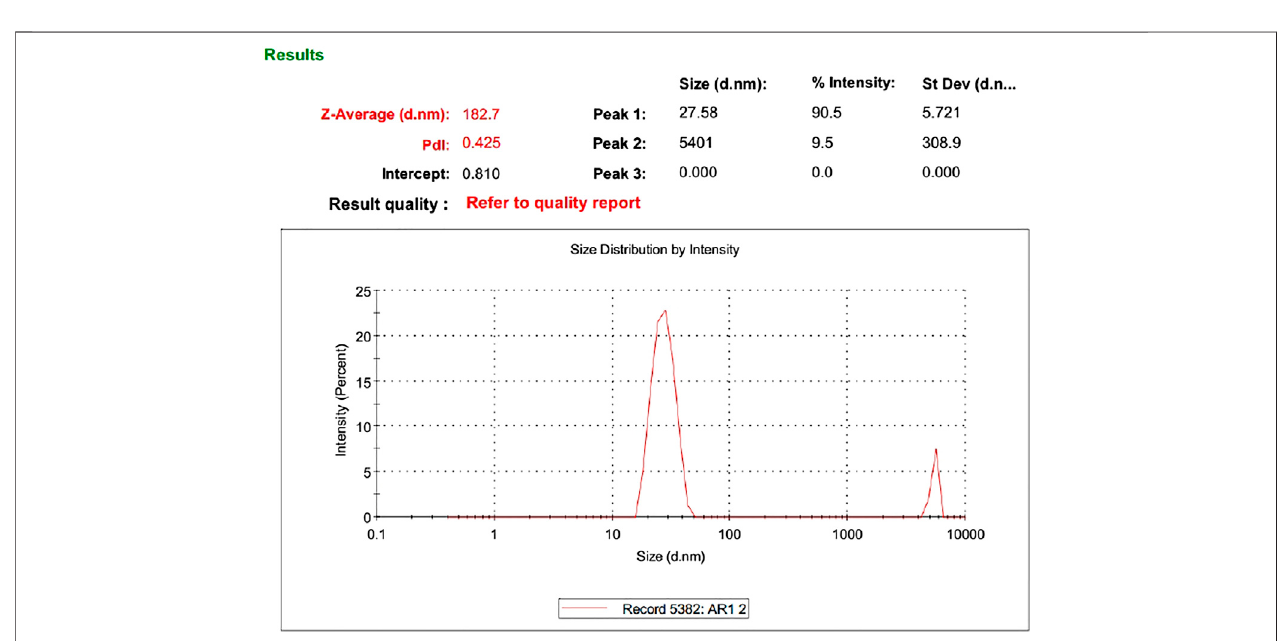
FIGURE 5 | Size of optimized